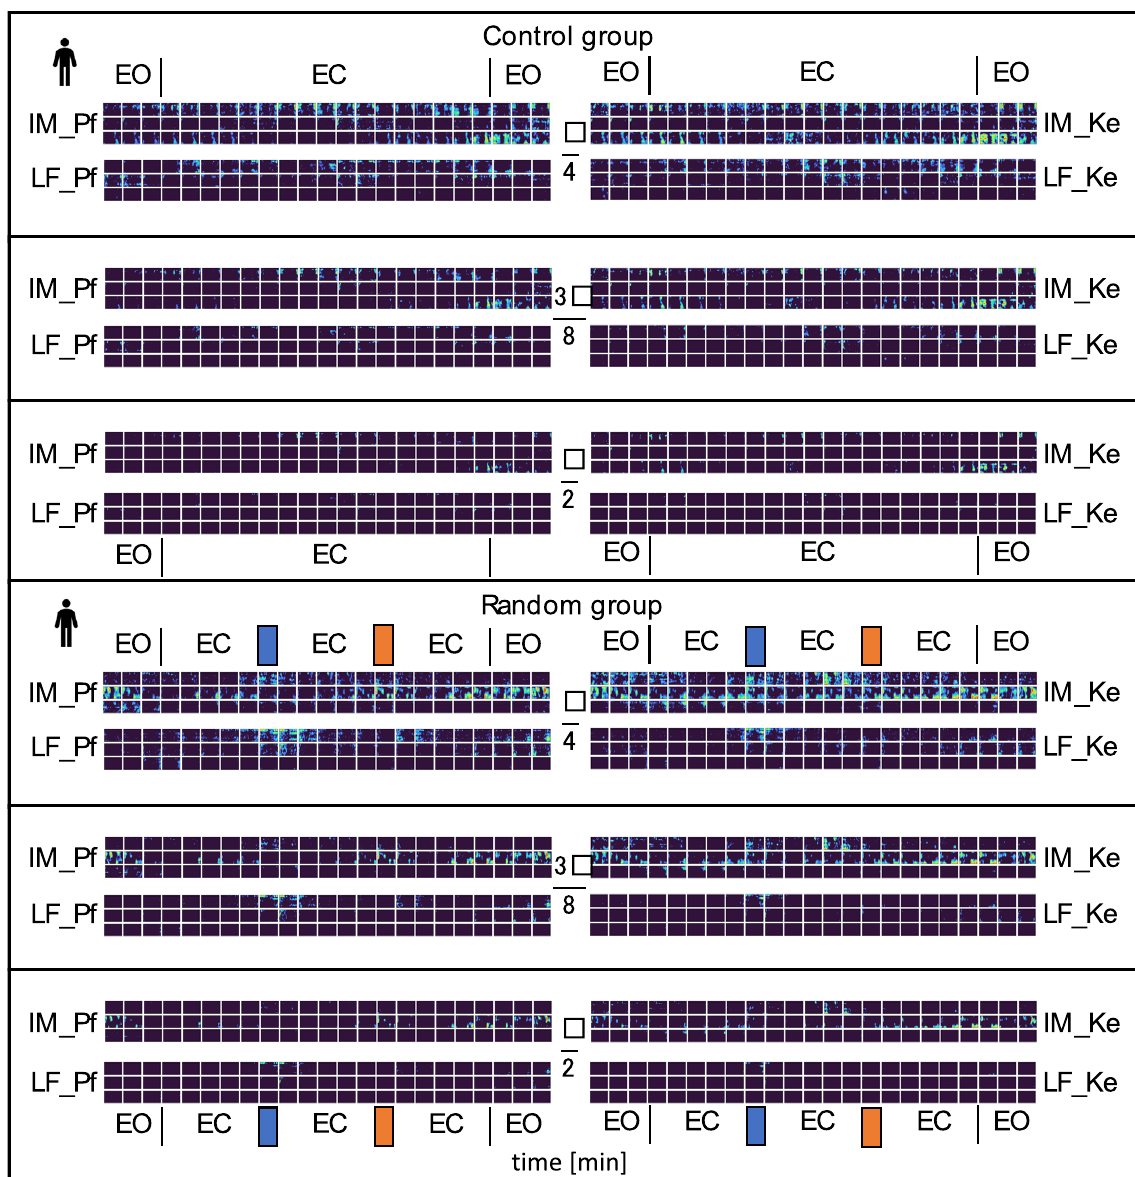
Figure 12. Spatial phase shift distribution matrices indexing desynchronization for low and intermediate frequency (LF, and IM, resp.) bands according to boundaries used by Pfurtscheller (Pf, left column) or Keller (Ke, right column) for individual participants (horizontal lines of squares) control and random groups. EO = eyes open, EC = eyes closed; orange bar at top: cold water test, blue bar at top: ambient water test. From top to bottom, colour coded points display thresholds for relative phase shift intervals from π/4 rad to π rad, 3π/8 rad to π rad, and π/2 rad to π rad: dark blue < blue < green < yellow. Red indexing counterphase with the